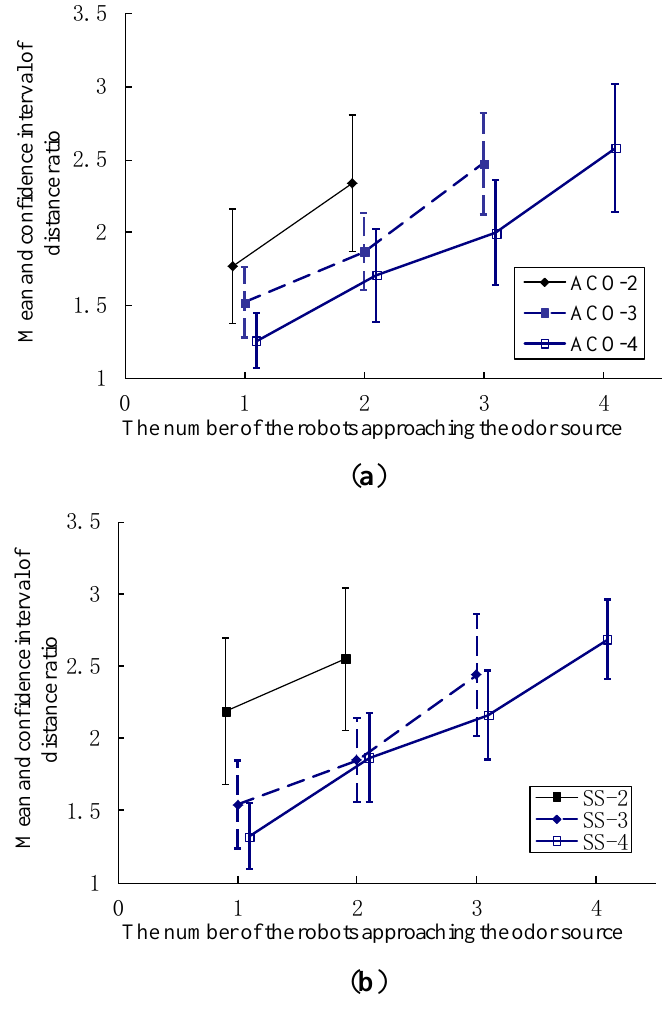
Figure 14. DR for real-robot experiments using the AACO+US and the SS algorithms in n Arena I. ( a ) AACO+US algorithm; ( b ) SS strategy.